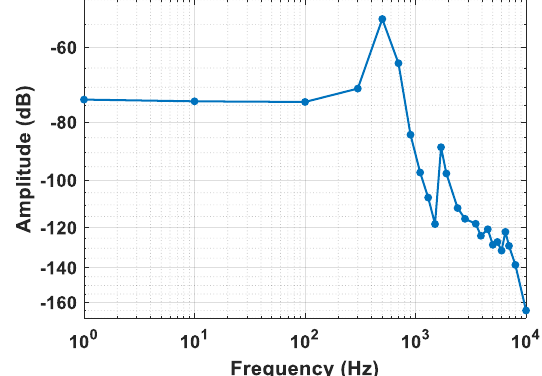
Fig. 7. Frequency response of the proposed fiber sensor.